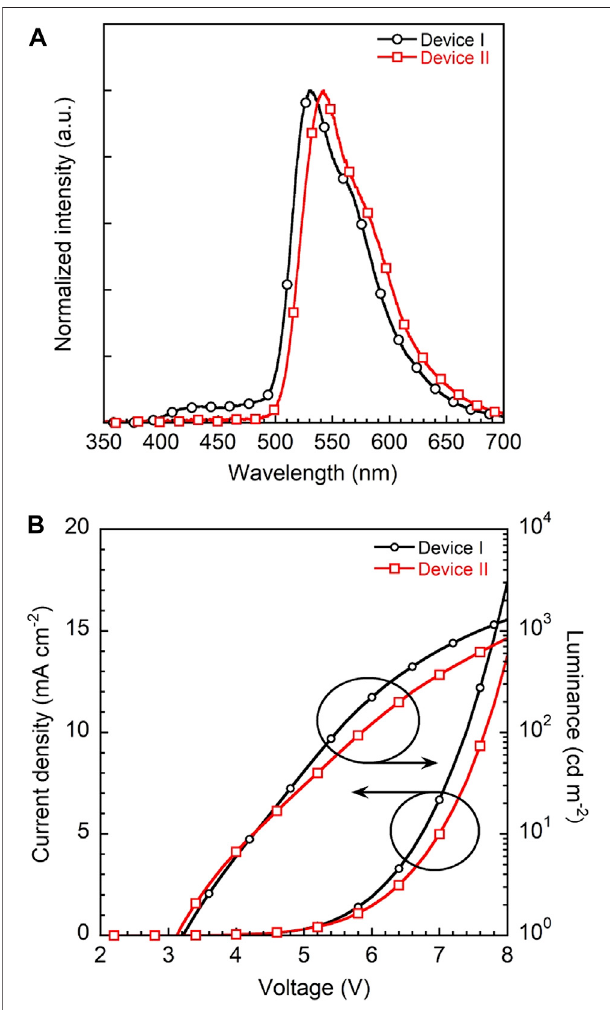
FIGURE8|(A) ELspectraofdevicesIandIIwith1and5 wt% 3a -doped CBP as an emissive layer, respectively and (B) current density-voltage- luminance (J-V-L) plots of two devices.